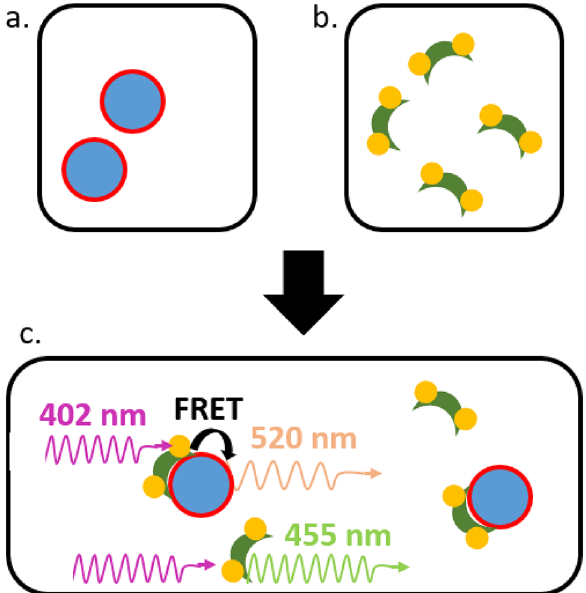
Figure 1. Stopped-flow experiment to obtain k on and k off of ENB with lipid membranes. Pacific blue (PB)- labeled ENB (a) is mixed with NBD-containing LUVs (b) of different concentrations. (c) FRET between two fluorophores causes the emission intensity of PB (EX: 402 nm), the donor, to decrease (collected with 440/40 nm filter) when ENB is membrane bound (top), relative to PB dyes on ENB that is not bound to membranes (bottom). Such decrease reflects the binding of ENB onto the LUV surface. The relation between obtained binding rates k obs and the lipid concentration can be used to obtain k on and k off